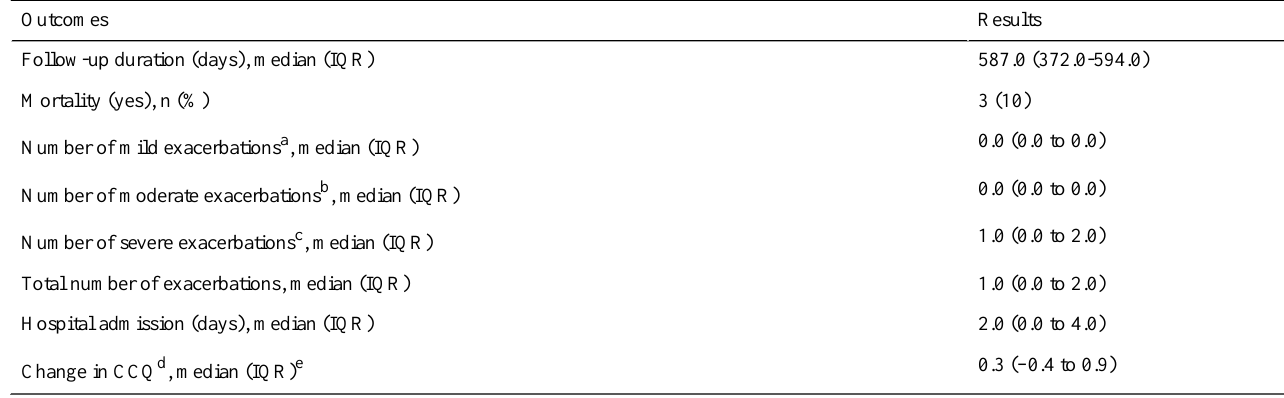
Table 2. Follow-up at 12-18 months after initiation of EmmaCOPD (n=29).